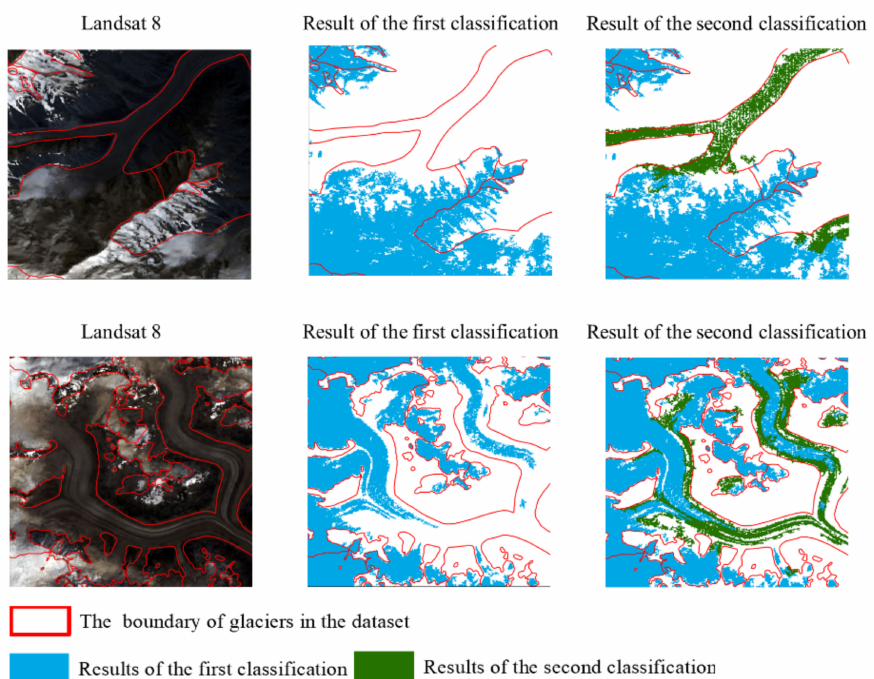
Figure 10. Details of glacier extraction results on the Tibetan Plateau. The red line is the boundary of glaciers in the dataset.